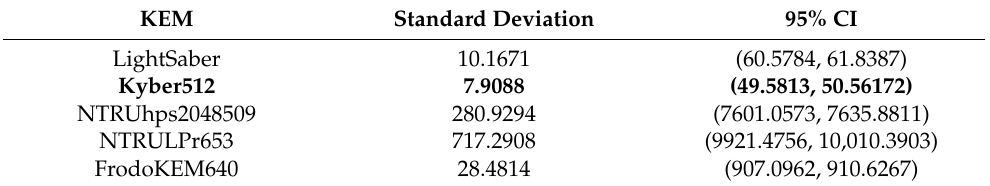
Table 5. The standard deviation and 95% CI values of CPU usage for the operation key generation , for each of the KEMs.